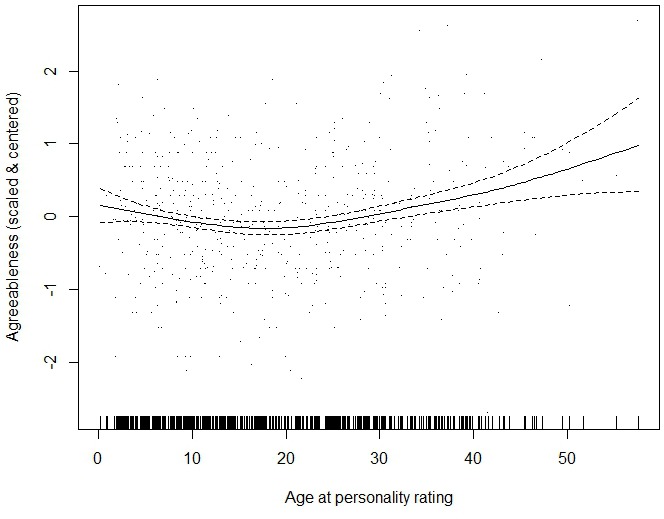
Generalized additive model of agreeableness and age at personality rating.The carpet and scatter plot present the distribution of observations over which the best fit smoothed regression line is plotted with the 95% confidence region.